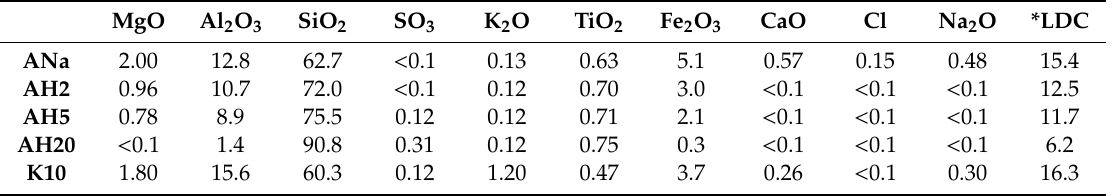
Table 3. Chemical composition of the Mt. The ratios are presented in % m /